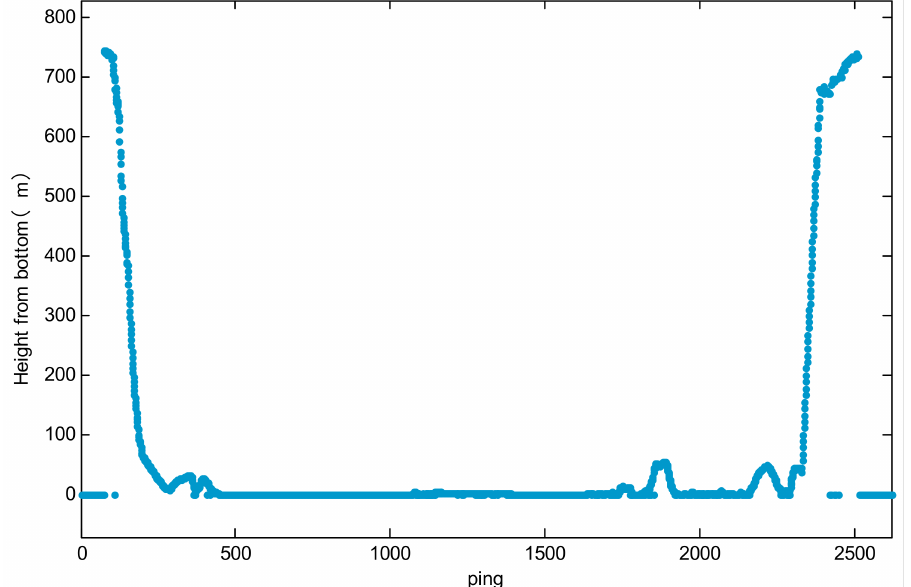
Figure 20. Measurement values of the